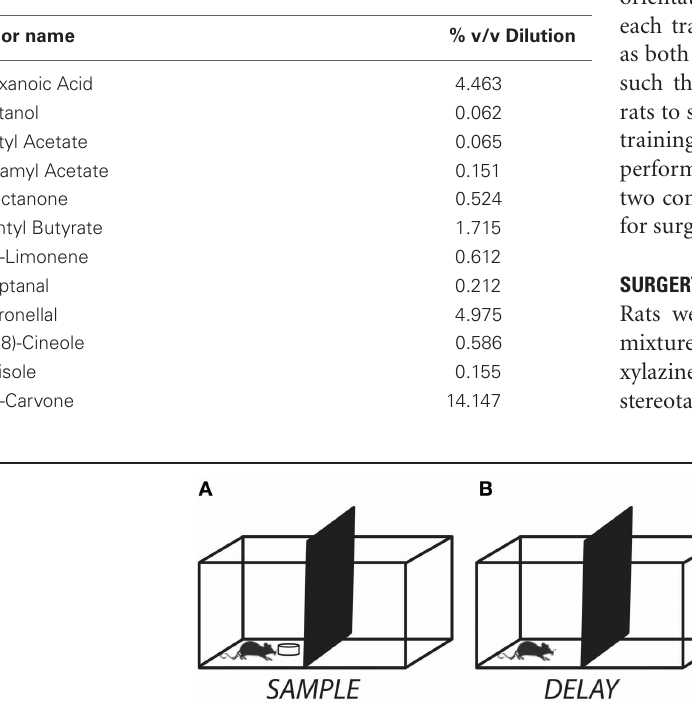
(C) Attheendofthedelayperiod,thedividerwasraisedandtheratmovedtothe test chamber and had to discriminate between a dish containing the matching odor (rewarded) and one containing a non-matching odor (unrewarded). A trial wascounted ascorrect ifthe ratinitiated digging inthe matching odor dish